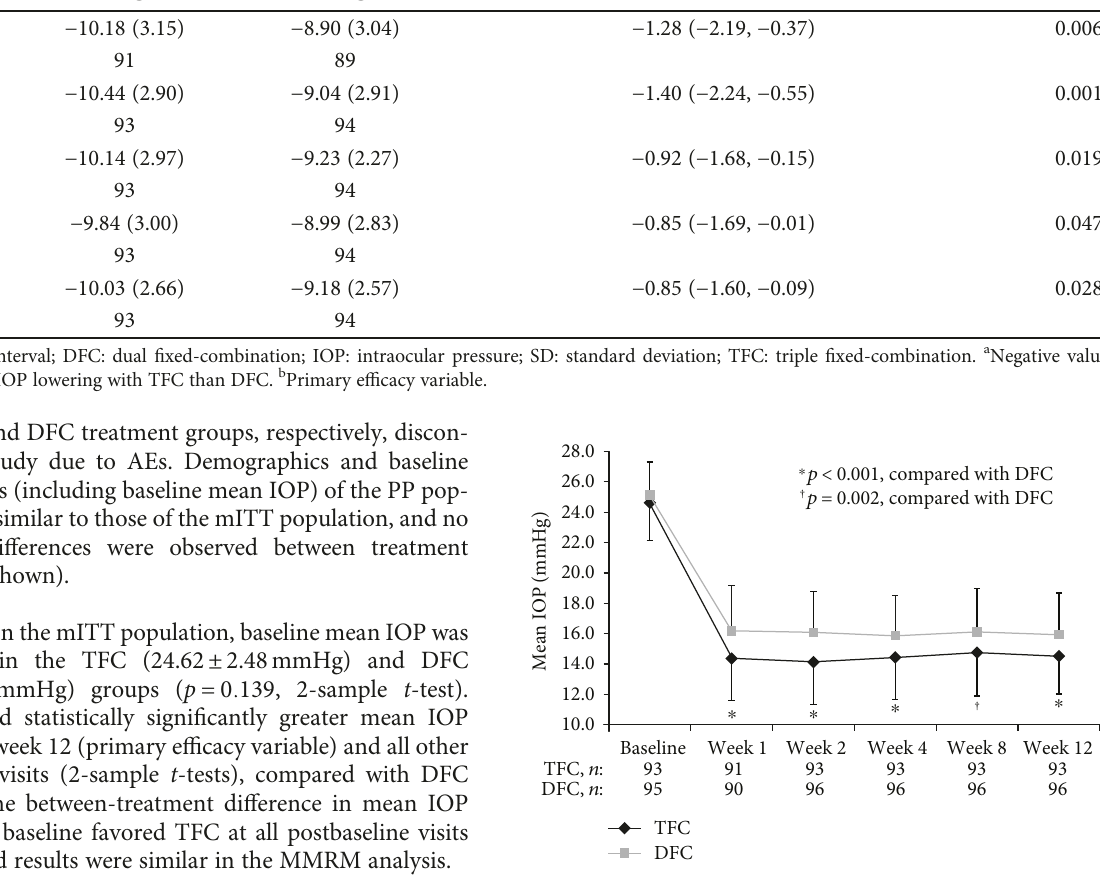
Figure 1: Mean intraocular pressure (IOP) at each visit in the modi fi ed intent-to-treat population. Data are presented as mean + standard deviation (SD) for TFC and mean − SD for DFC. Statistical signi fi cance was determined using the 2-sample t -test. DFC: dual fi xed-combination; TFC: triple fi